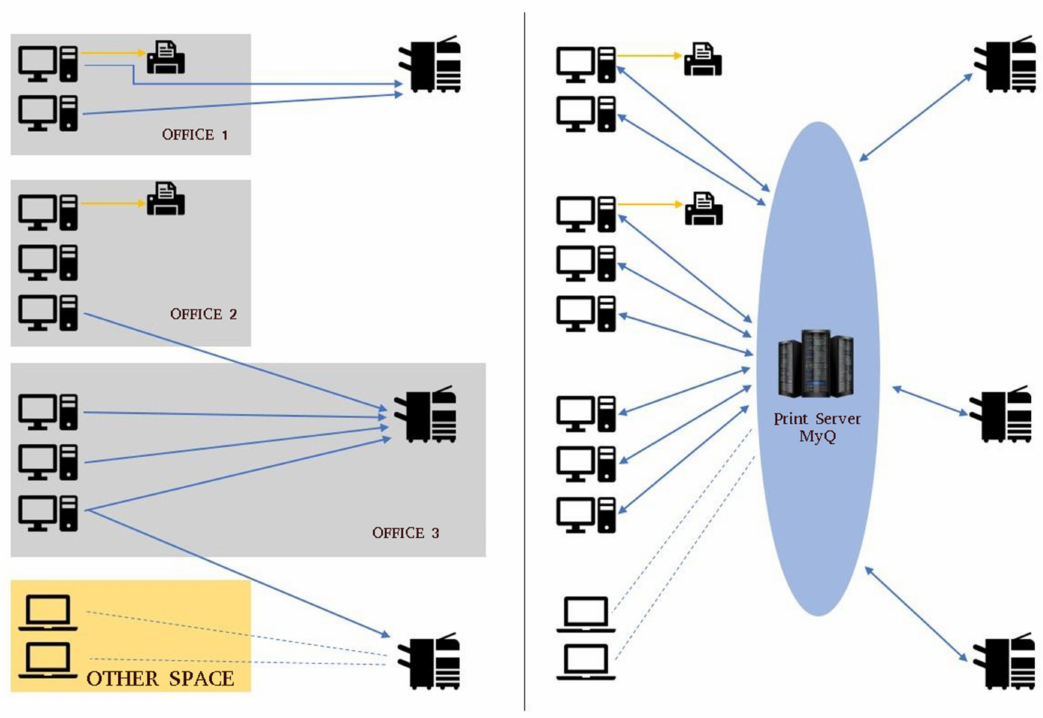
Figure 8. Diagram showing the layout of the print infrastructure in the pre- and post-implementation states of the new system. Source: custom processing.